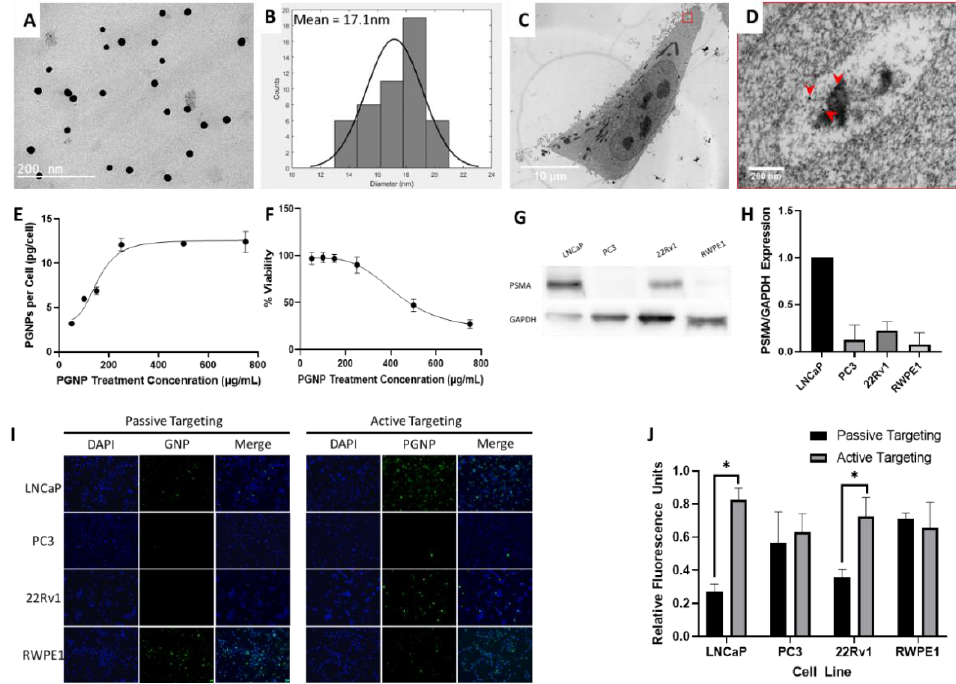
Figure 1. ( A ) TEM image of PSMA-antibody conjugated gold nanoparticles (PGNPs). ( B ) Histogram of PGNP diameters (mean = 17.1 nm ± 0.28 nm) from TEM images. ( C ) Representative TEM image of a LNCaP cell treated with 250 µg/mL of PGNPs. ( D ) Magnified region with arrow heads indicating internalized PGNPs. ( E ) PGNP uptake in LNCaP cells after 24 h of treatment at various PGNP doses (50 µg/mL, 100 µg/mL, 150 µg/mL, 250 µg/mL, 500 µg/mL, 750 µg/mL). ( F ) Percentage viability of the LNCaP cells incubated with different concentrations of PGNP (50 µg/mL, 100 µg/mL, 150 µg/mL, 250 µg/mL, 500 µg/mL, 750 µg/mL). ( G ) Western blot for PSMA expression in whole cell lysate of LNCaP, PC3, 22Rv1 (prostate cancer), and RWPE1 (normal prostate) cells. ( H ) Quantification of PSMA expression in the western blot normalized to a GAPDH signal. ( I ) Fluorescence microscopy image of LNCaP, PC3, 22Rv1, and RWPE1 cells treated with 250 µg/mL of passive targeting (mouse IgG conjugated) GNPs and active targeting (PSMA-antibody conjugated) PGNPs. ( J ) Quantification of fluorescence microscopy normalized to the highest signal in each cell line. * Denotes p<0.05 from Welch’s t-test.